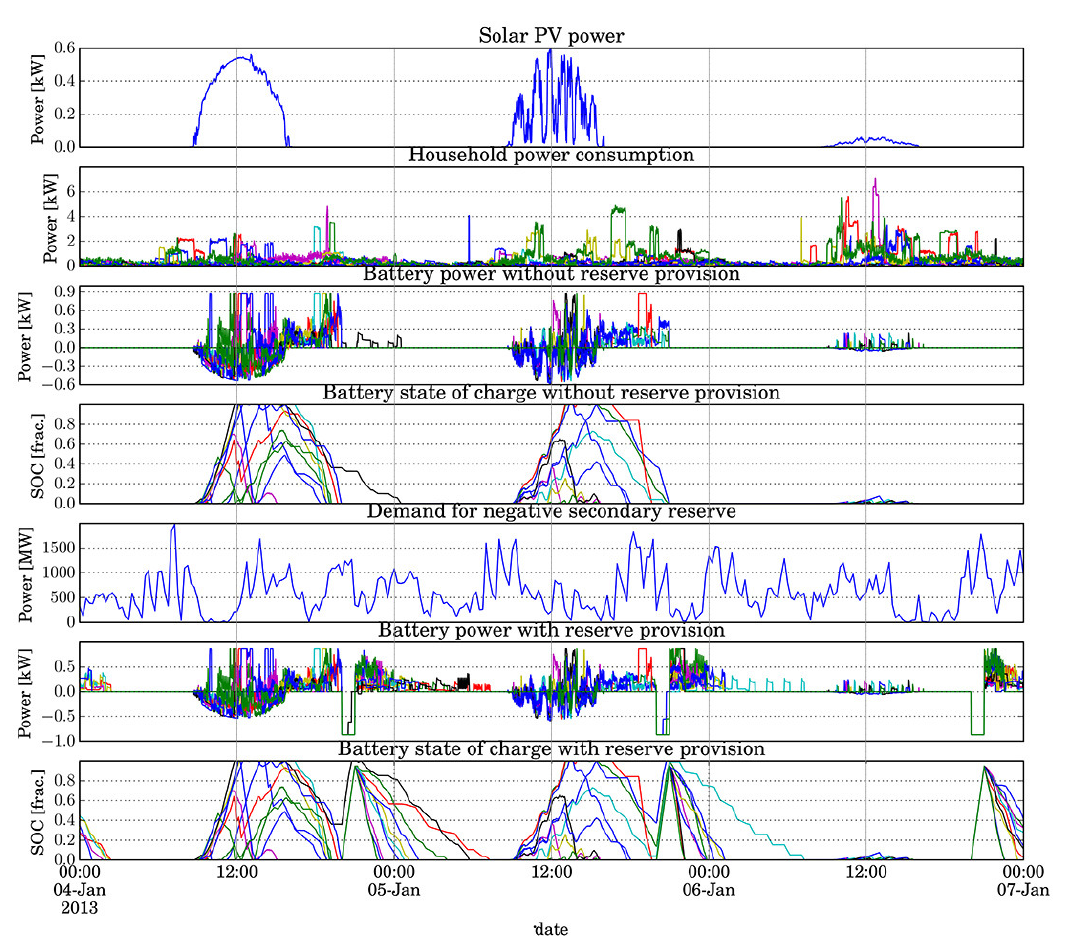
Figure 4. Selected input traces and modelled results of 10 single-person households for the simulation case CAP PV = 1 kWp and CAP B = 1 kWh. Each household is represented by a different colour and the plot illustrates the stochasticity of household electricity